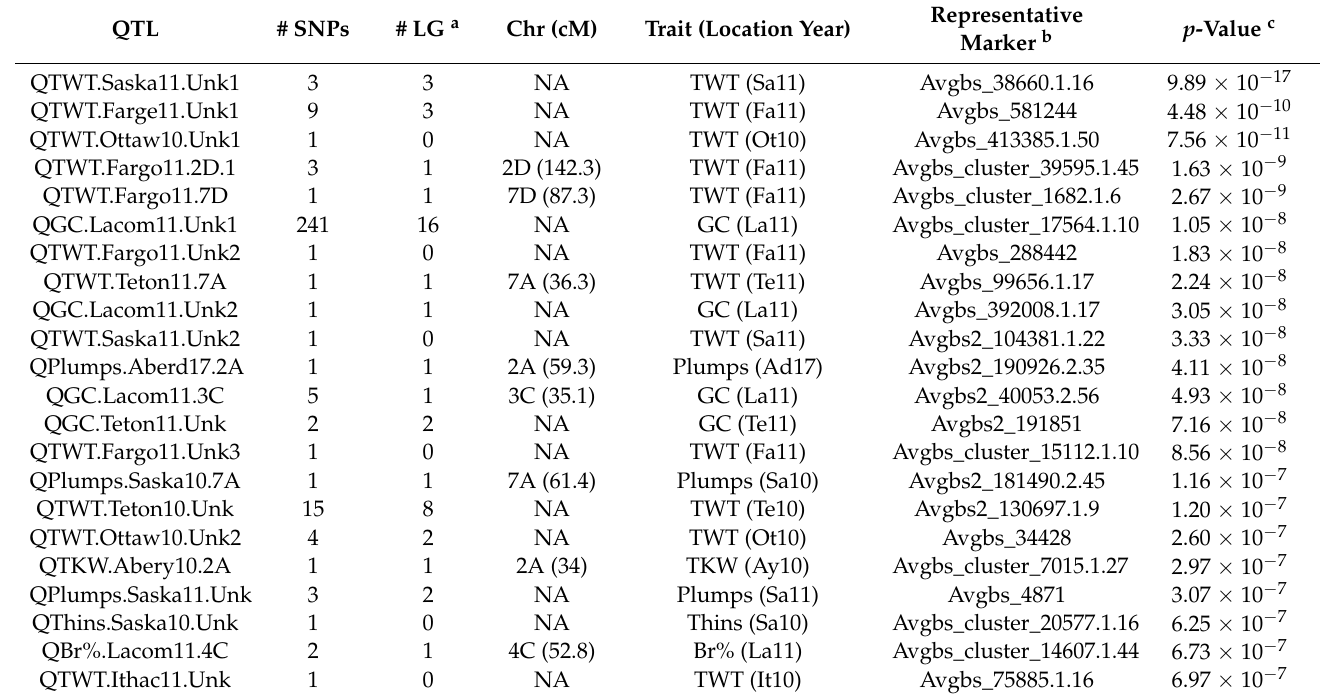
Table 5. Summary of quantitative trait loci associated with milling trait means in single location years. The number of non-independently associated SNPs, the number of linkage groups represented, trait (and context) and the p -value for the representative marker are indicated. p -values for all markers associated with these QTL in all experiments are presented in Supplemental Table